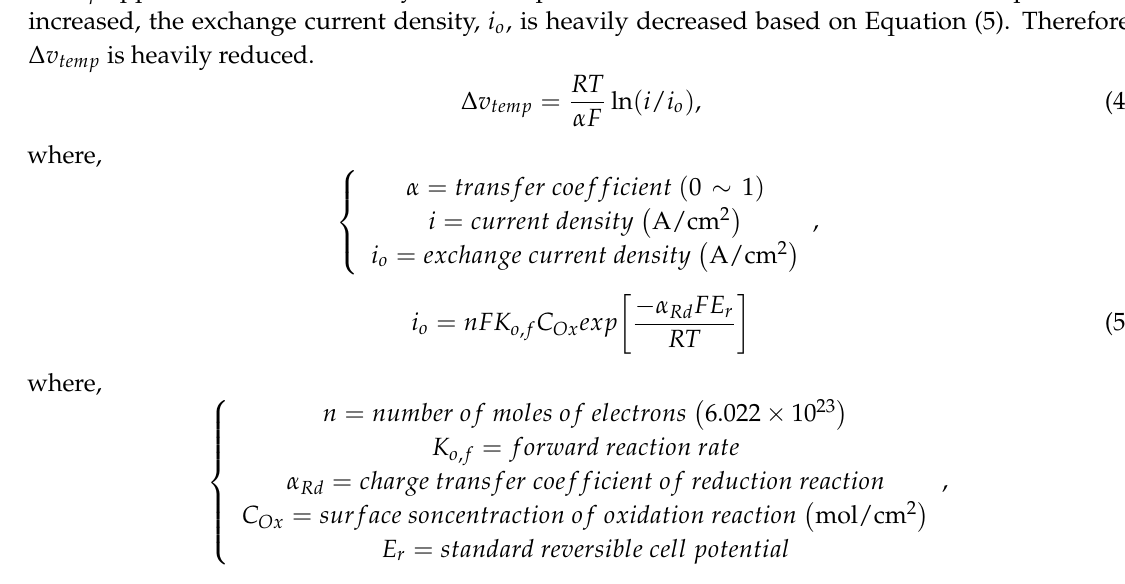
Figure 5. Voltage characteristic curve depending on the temperature of fuel cell stack. The voltage drop ∆ v temp is predicted, as shown in Equation (4) from the Butler Volmer equation. ∆ v temp appears to increase linearly as the temperature increase. However, when the temperature